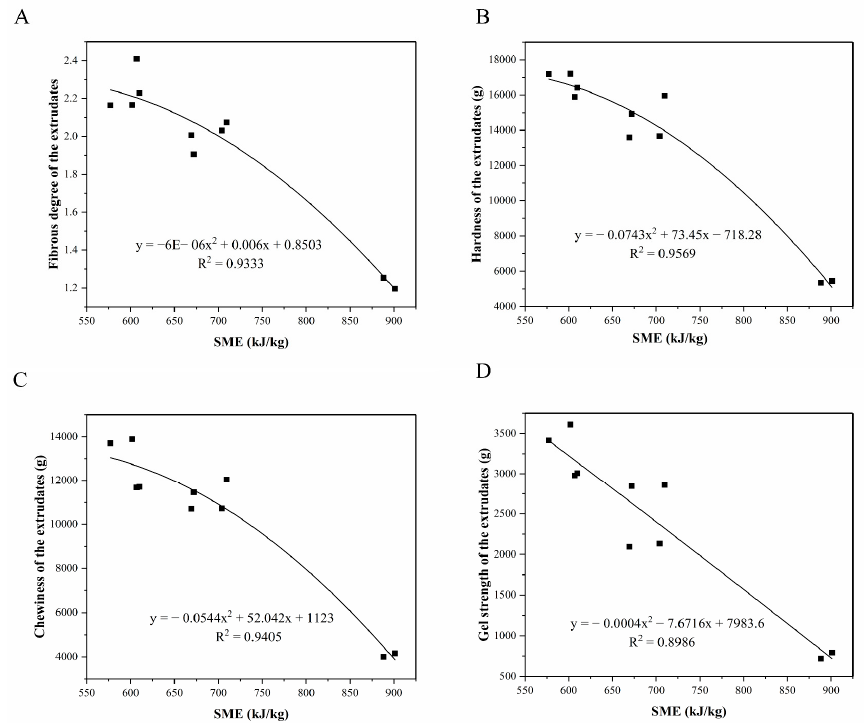
Figure 7. Relationships between the SME and the fibrous degree ( A ), hardness ( B ), chewiness ( C ) and gel strength ( D ) of the extrudates. gel strength ( D ) of the